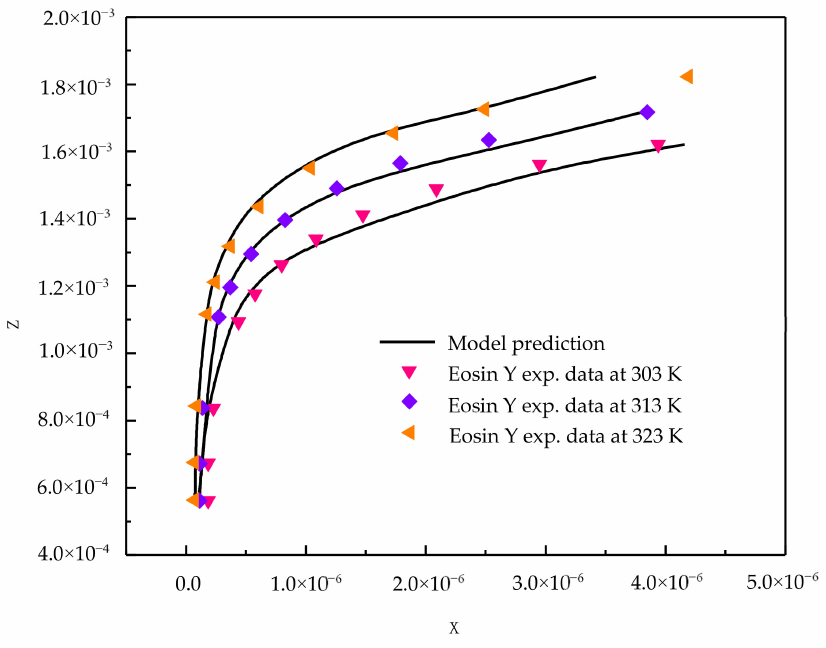
Figure 2. New model correlations for eosin Y dye-activated carbon system at various